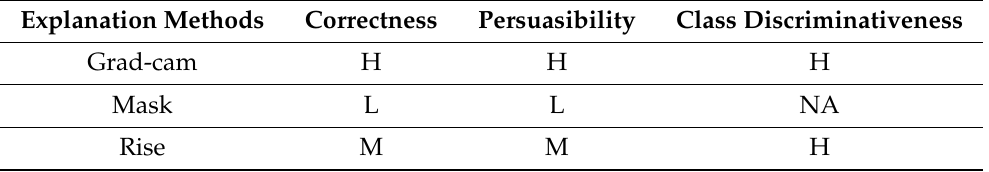
Table 8. Comparison of the considered visual explanation method. Different marks are provided: “H” (High), “M” (Medium), “L” (Low) or NA (Not